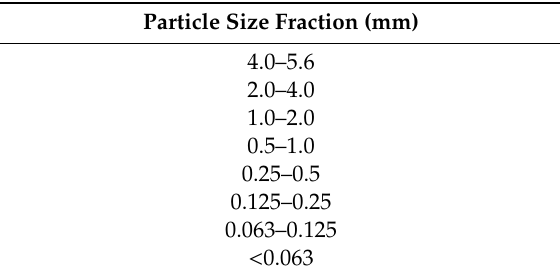
Table 1. Class size fractions for the geochemical and mineralogical characterization.